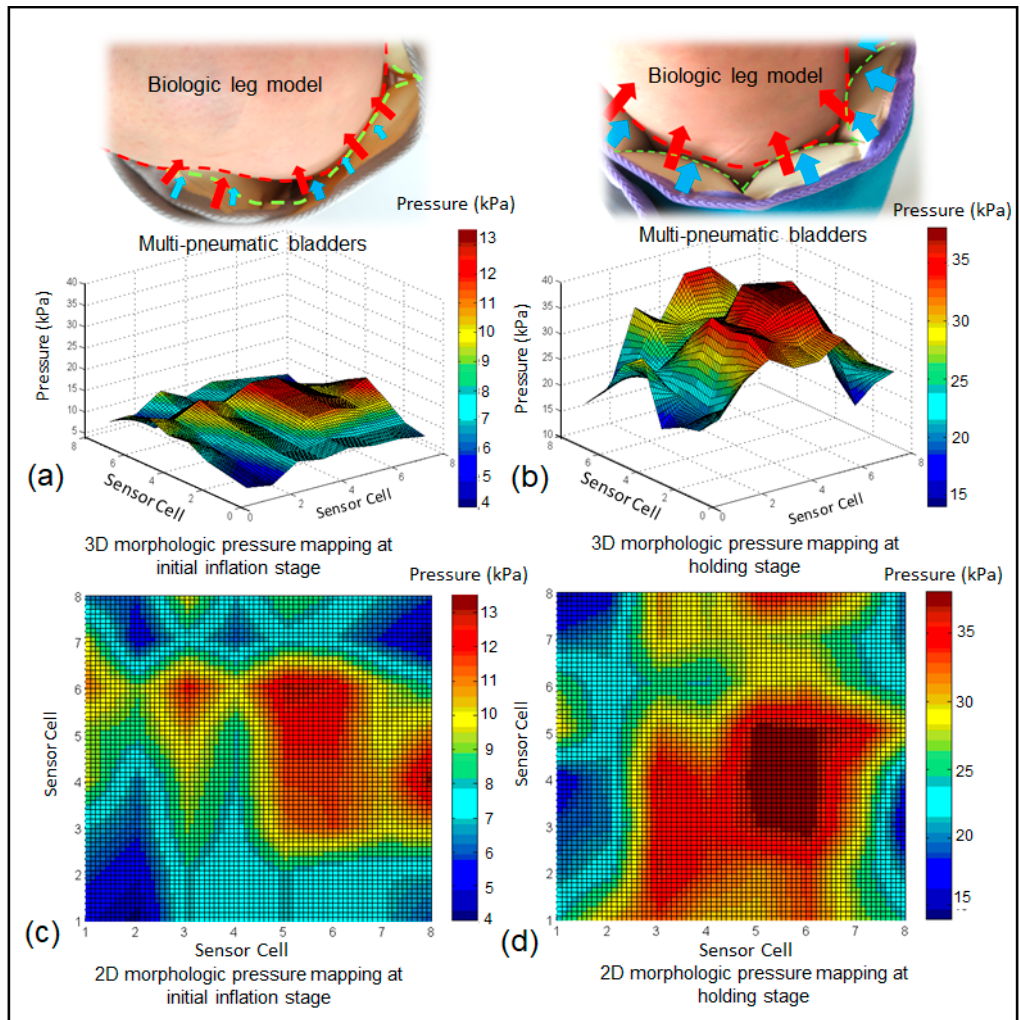
Figure 15. The 3D and 2D morphological pressure mapping detected by the developed dynamic interface pressure monitoring system at different stages of compression cycles by IPC in vivo. ( a ) 3D morphologic pressure mapping at initial inflation stage, ( b ) 3D morphologic pressure mapping at holding stage, ( c ) 2D morphologic pressure mapping at initial inflation stage, ( d ) 2D morphologic pressure mapping at holding stage.